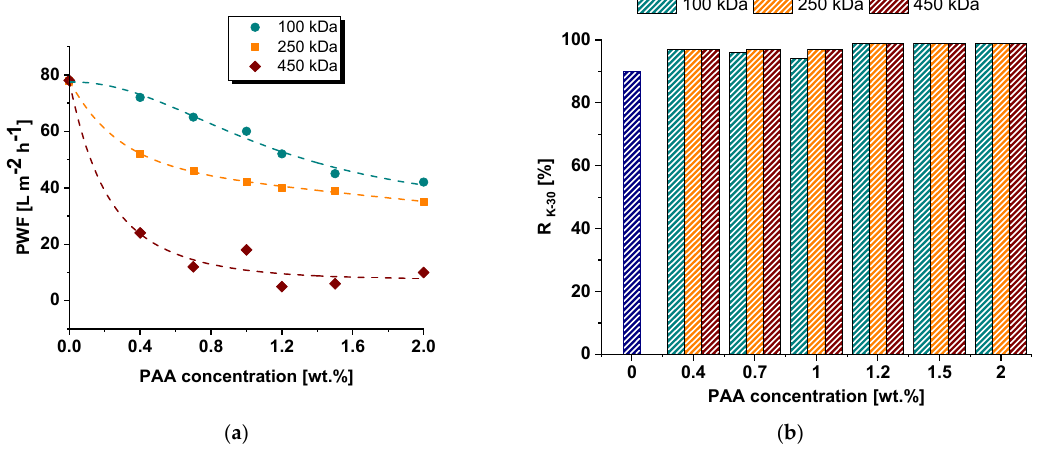
Figure 8. Pure water flux ( a ) and PVP K ‐ 30 rejection coefficient (R K − 30 ) ( b ) versus PAA concentration in the coagulation bath. It was revealed that the addition of PAA to the coagulation medium yields an in ‐ crease in PVP K ‐ 30 rejection regardless of the molecular weight of PAA from 90% for the reference membrane for up to 97–99% for the membranes modified with PAA due to de ‐ crease in pore size of the selective layer (Figure 8b). Lysozyme solution flux also declines when PAA is introduced to coagulation medium and PAA concentration increases (Fig ‐ ure 9a). It was found that the addition of PAA with molecular weights of 100,000 and 250,000 g ∙ mol − 1 to the coagulation bath results in similar values of flux at practically all studied PAA concentrations. However, the lysozyme solution flux of membranes modi ‐ fied with PAA with 450,000 g ∙ mol − 1 is lower (Figure 9a). It was revealed that lysozyme rejection substantially increases from 53% for the reference PSF membrane to 78–80% for modified membranes when 0.4 wt.% PAA is added to coagulation bath (Figure 9b). This is attributed to the decrease in the pore size of the membrane selective layer (Figure 4). The increase in concentration and PAA molecular weight leads to the increase in lyso ‐ zyme rejection, reaching 96–99% for membranes modified by the addition of more than 1 wt.% of PAA with molecular weights of 250,000 and 450,000 g ∙ mol − 1 . It is worth noting that the lysozyme molecule and membrane surface are oppositely charged at pH = 7.2–7.4. Along with extremely high hydrophilicity, an opposite surface charge has to fa ‐ cilitate lysozyme penetration through the membrane. However, very small pore size